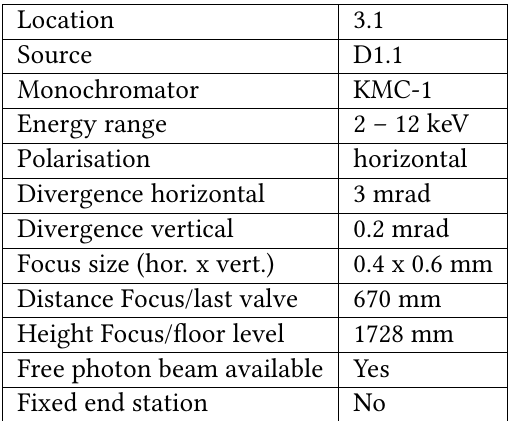
Table 2: Technical data of Beamline